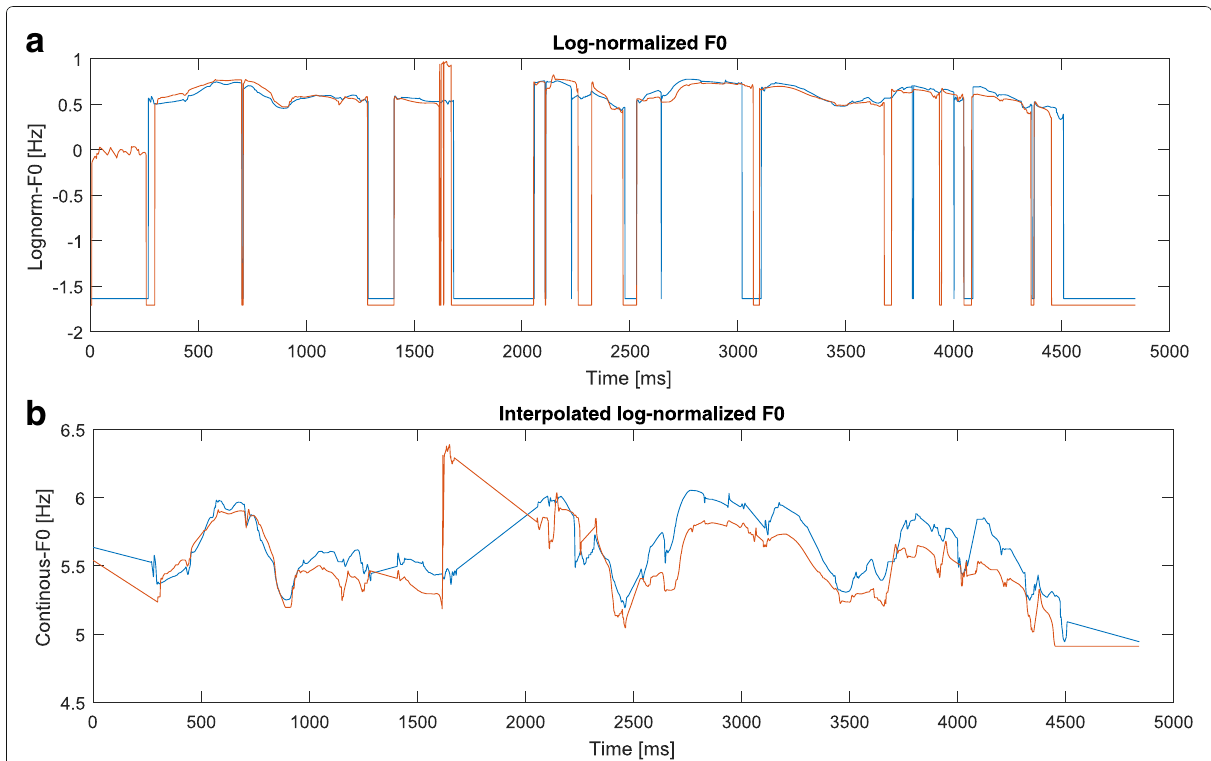
Fig. 1 Log-normalized F0 ( a ) and interpolated log-normalized F0 ( b ). The redcurve target F0; the bluecurve source F0